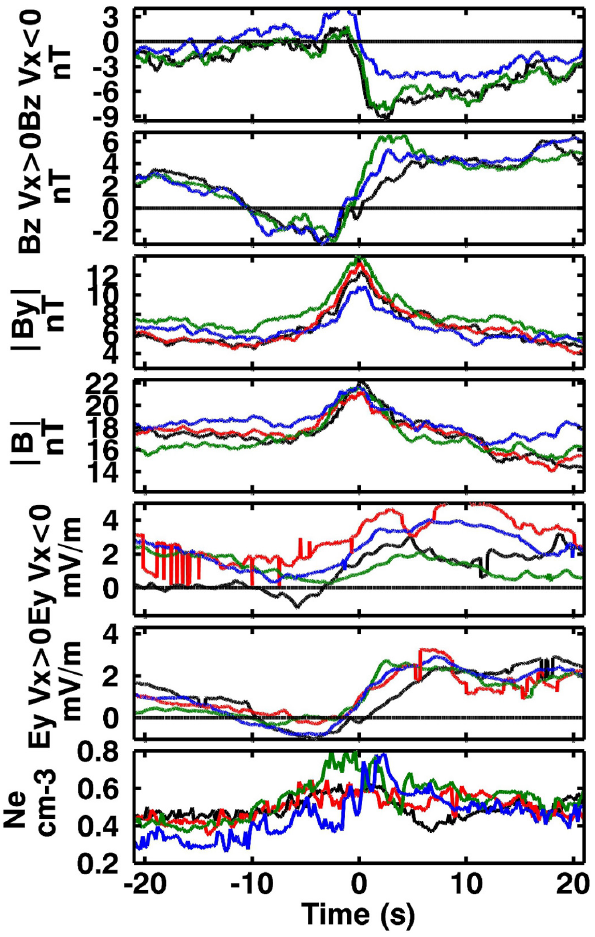
Fig. 4. Data from all spacecraft: SC1 black, SC2 red, SC3 green and SC4 blue. Average epoch presentation of the average of all ob- served flux ropes: B z earthward (nT) ( V ion x > 0) and tailward (nT) ( V ion x < 0) of the X-line site, | B y | (nT), | B | (nT) and E y earthward (mVm − 1 ), E y tailward (mVm − 1 ) of the X-line site (full resolution electric field filtered with a low pass filter) and the electron density (cm − 3 ). The time interval at the X-axis starts at 20s before the mid- dle of the flux rope is observed (at zero seconds) and stops at 20s